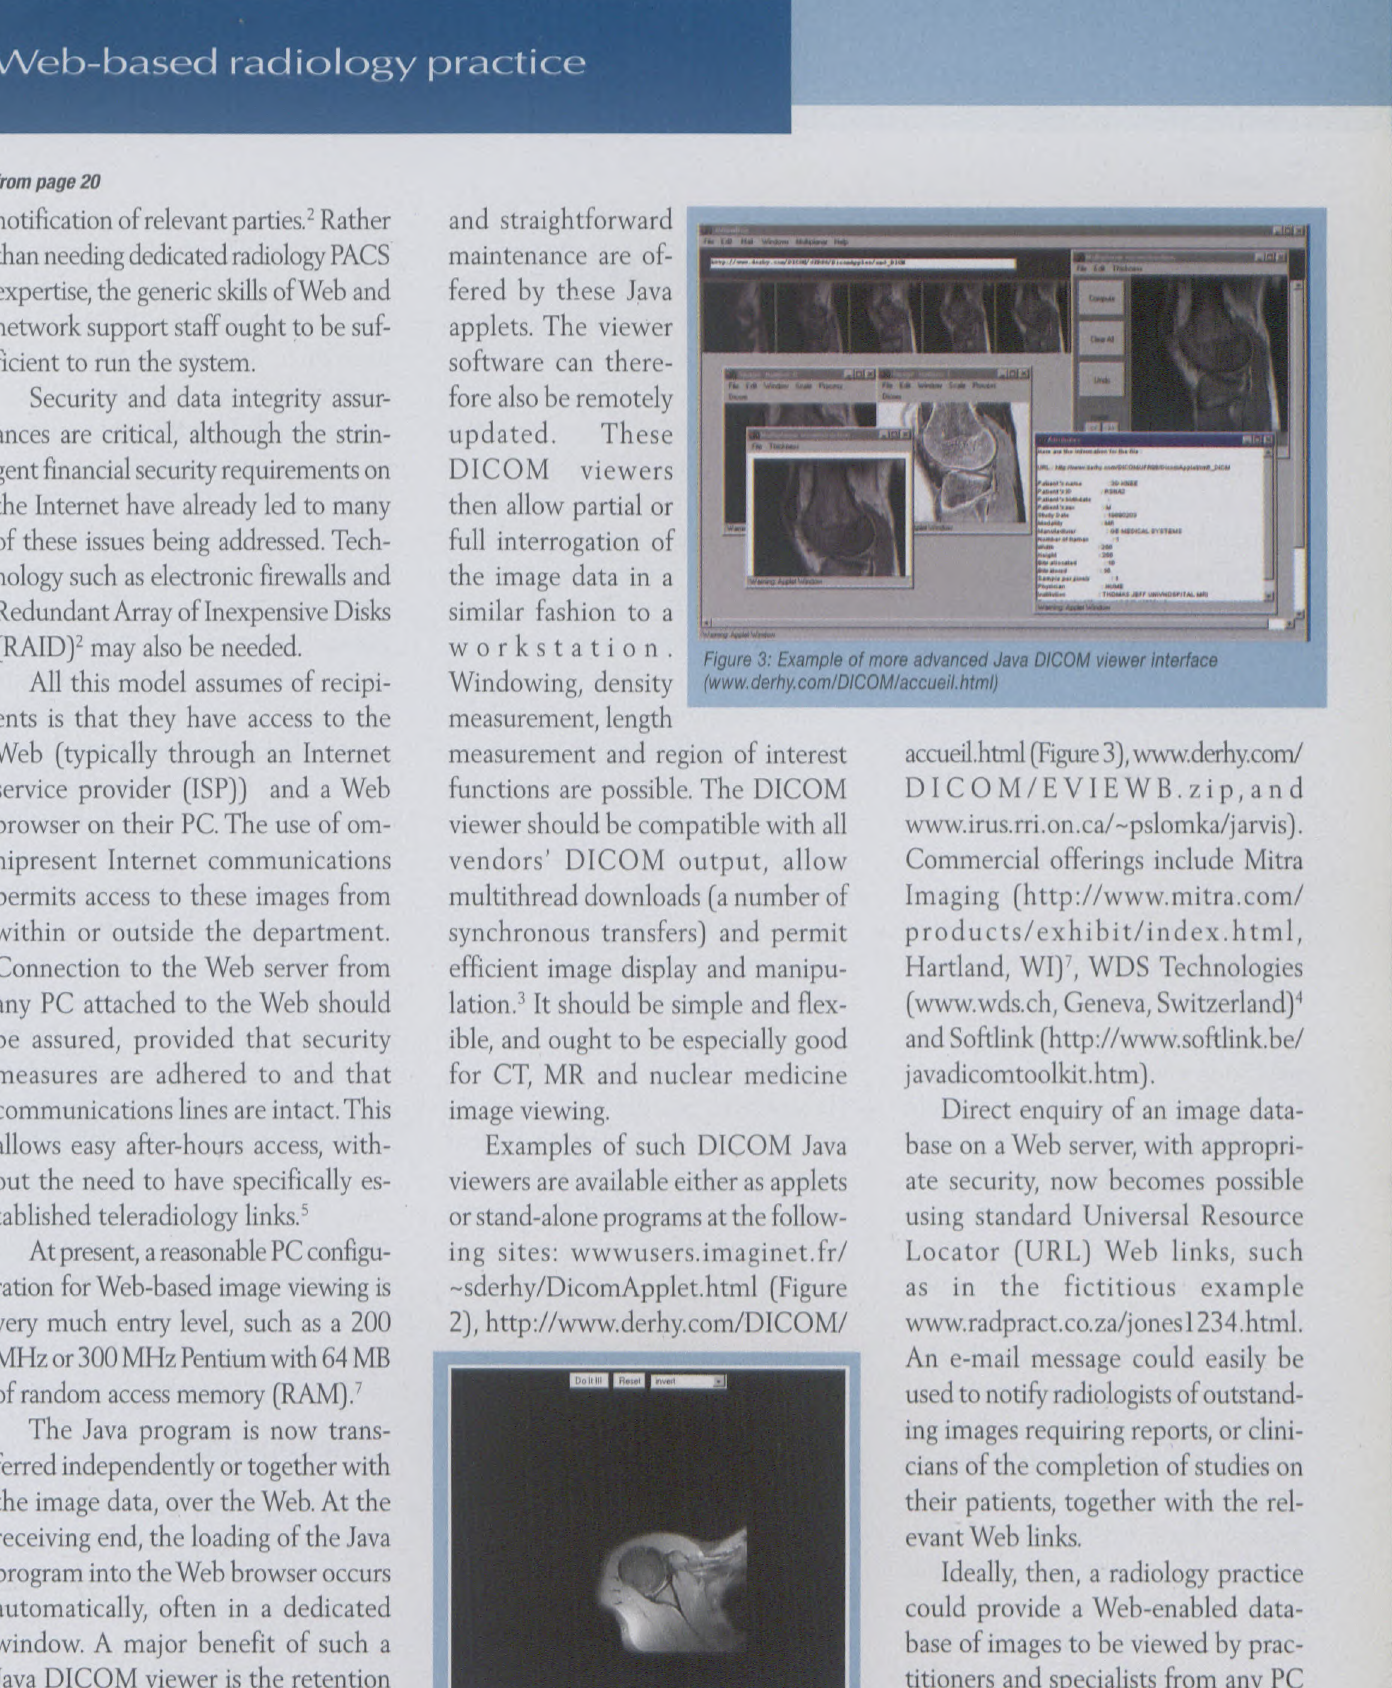
Figure 2: Example of simple Java DICOM viewer interface (wwwusers./magineUrl·sderhyl DicomApplet.